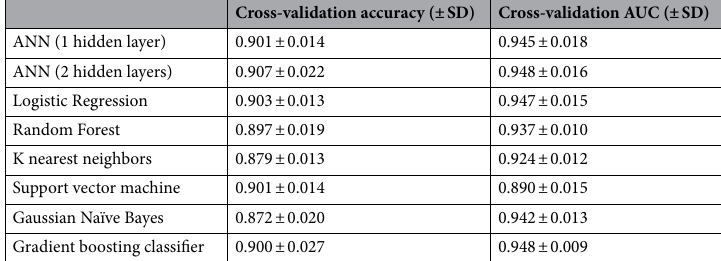
Table 2. Machine learning methods performance evaluation.